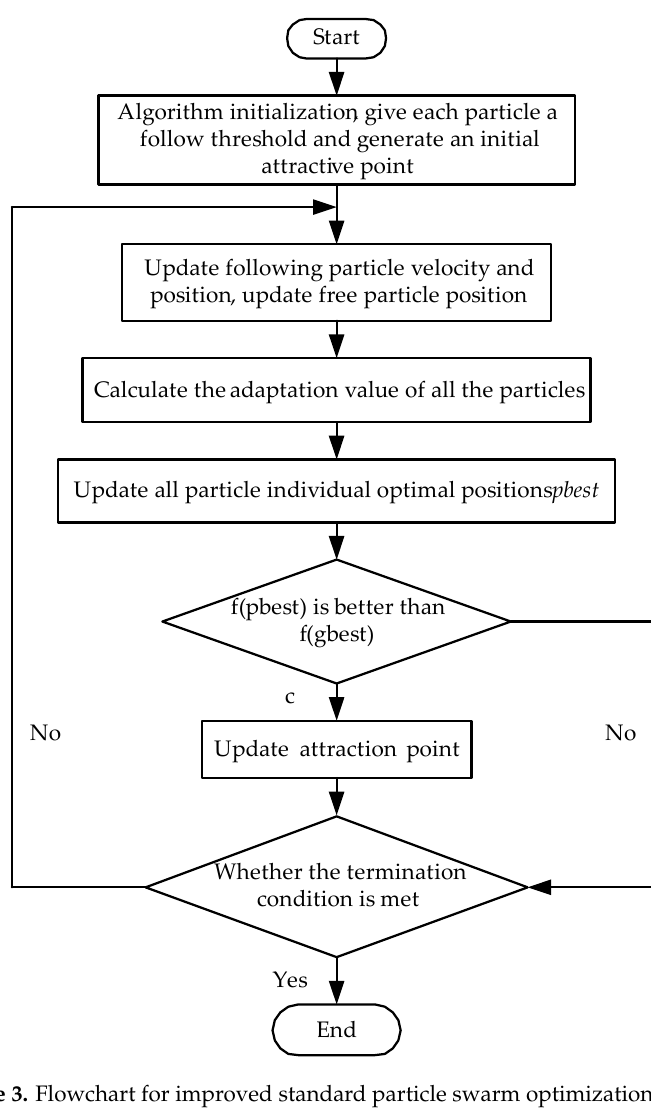
Figure 3. Flowchart for improved standard particle swarm optimization (SPSO).